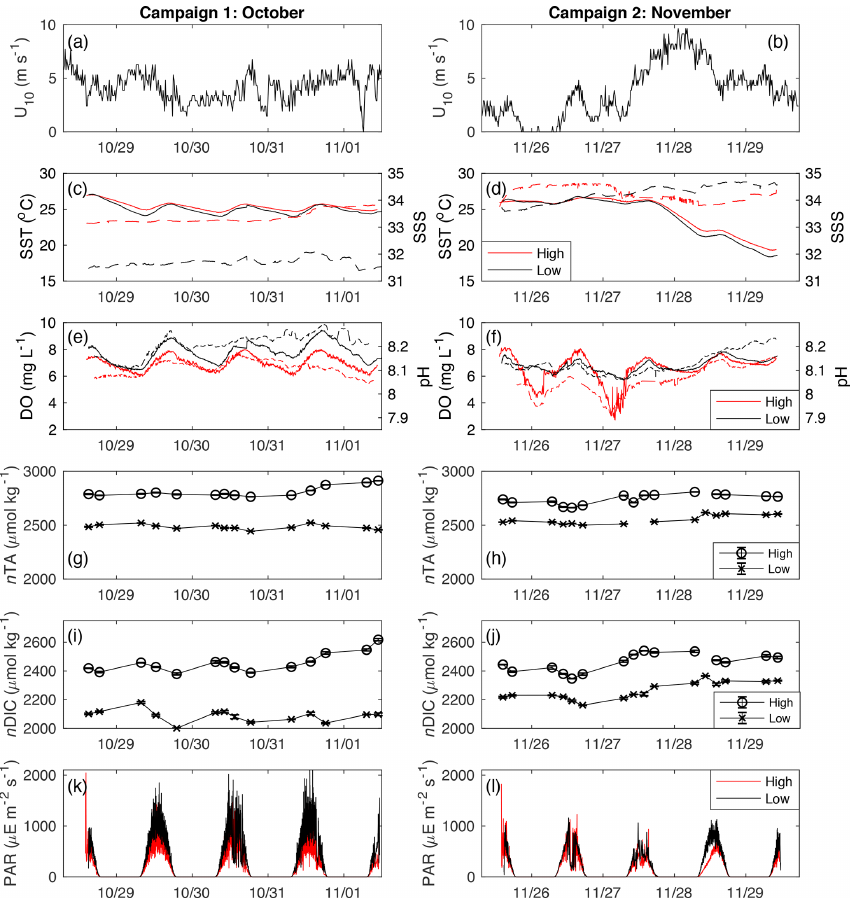
Figure 2. Time series of (a–b) U 10 (ms − 1 ), (c–d) SST and SSS, (e–f) DO (mgL − 1 ) and SeaFET pH, (g–h) n TA (µmolkg − 1 ), (i–j) n DIC (µmolkg − 1 ), and (k–l) PAR (µEm − 2 s − 1 ). For panels (c) – (f) , the solid lines are linked to the left axis, while the dashed lines are for the right